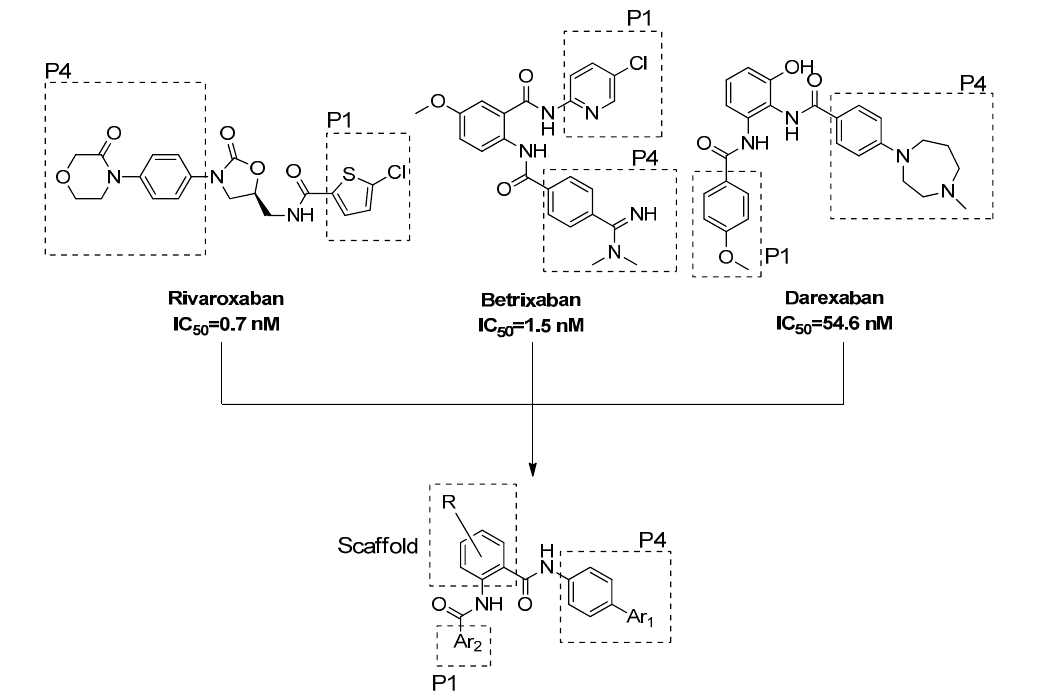
Figure 4. Design of anthranilamide-based FXa inhibitors.